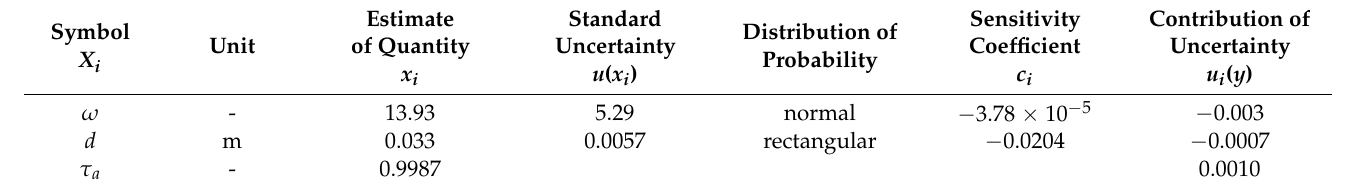
Table 2. Uncertainty budget τ a